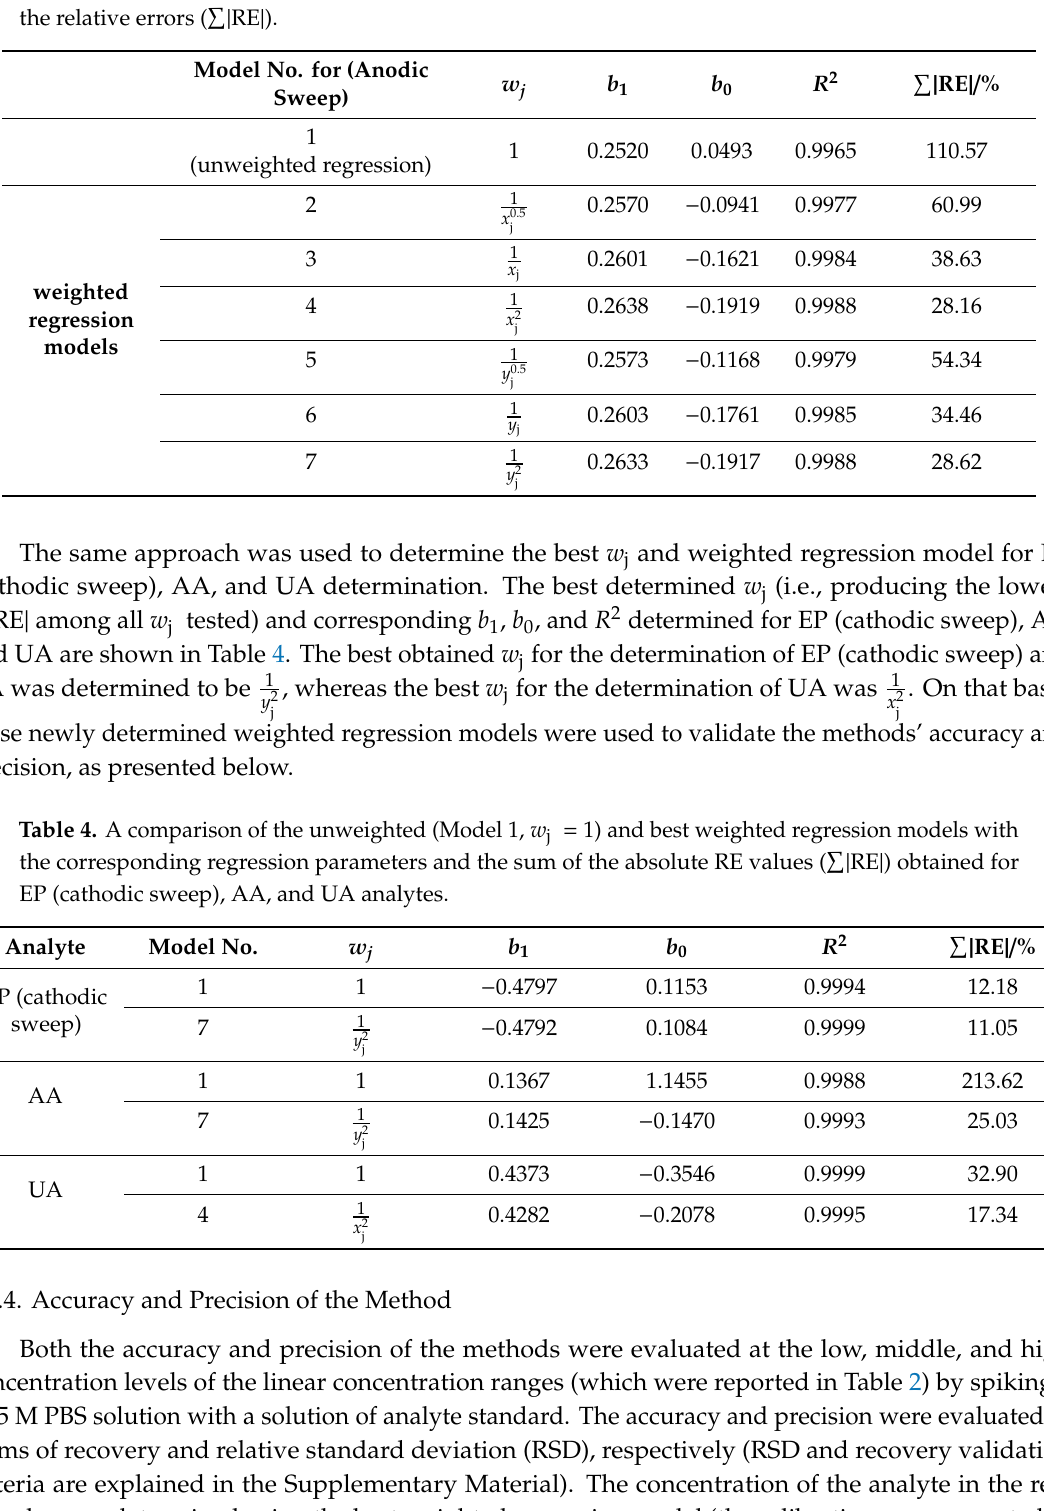
Table 3. The regression parameters of the unweighted regression model ( w j = 1) and the regression parameters of the weighted analytical models for EP (anodic sweep) with the corresponding sums of (cid:80) | the relative errors ( RE | ).